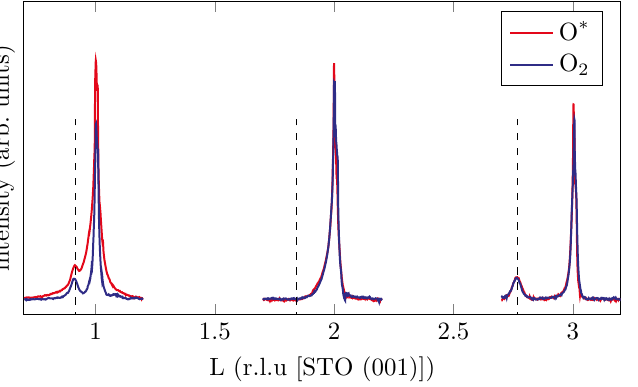
Figure 7. XRD measurements along (11L) CTR across the STO(11L) Bragg reflection. The dashed lines represent the peak positions of the oxide film. Bragg peaks can be identified close to the STO(111) and STO(113) reflex but not the STO(112). Thus, the oxide films have rock salt structure and do not show spinel